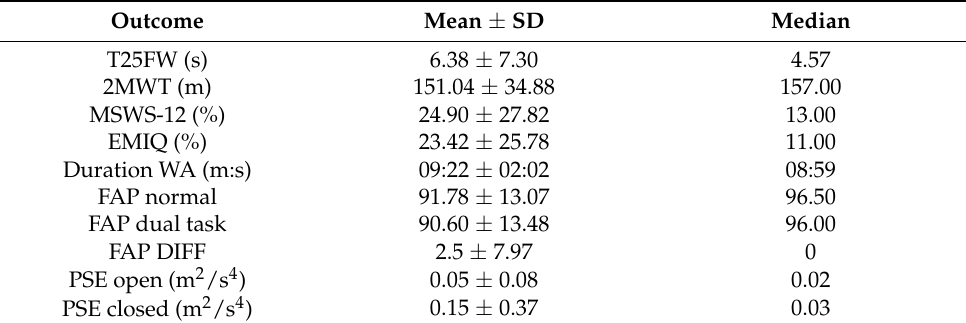
Table 2. Patient-reported outcome measures (PROMs) and gait parameters ( N =